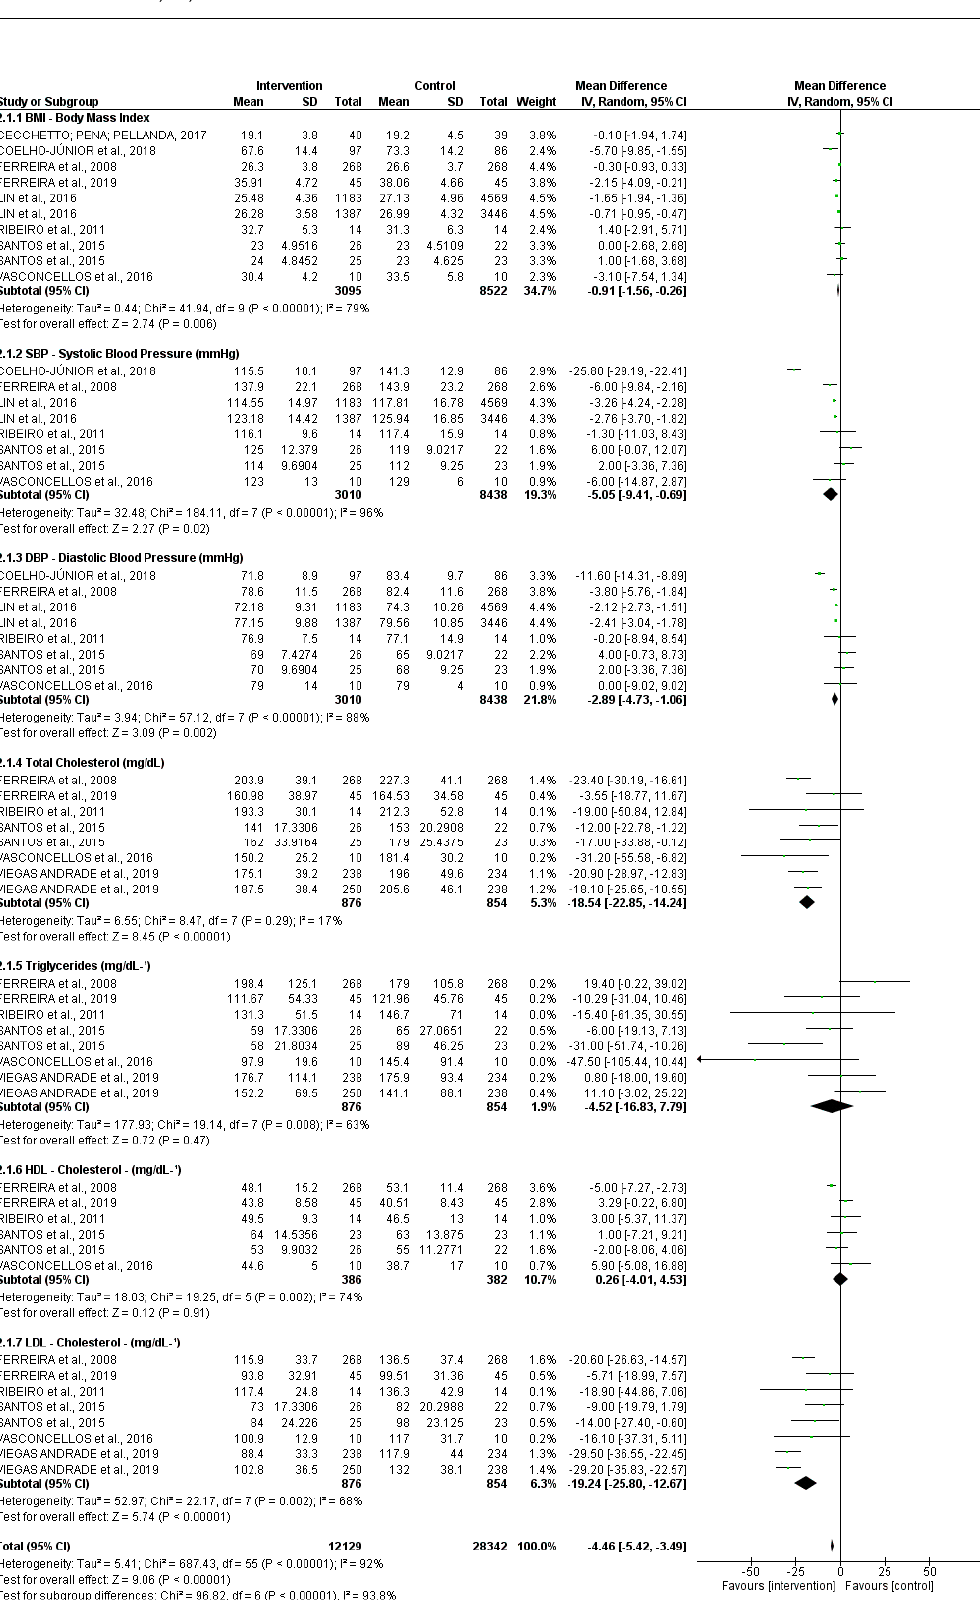
Scheme 3. Pooled meta-analysis of biomarker intervention studies. Source: prepared by the authors using RevMan® 5.4.1 software [33,37,73]. With the diamond set on the null line in the forest plot ( Scheme 3 ) and concentrated in the top-center of the funnel plot (Scheme 4), the expected decrease in high-density lip-